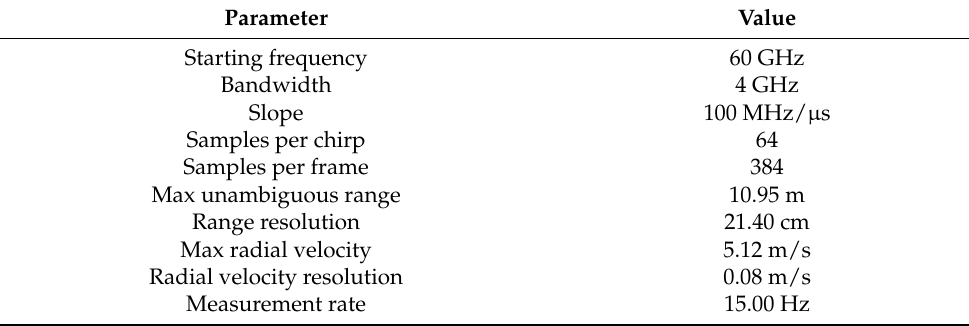
Table 1. FMCW radar configuration